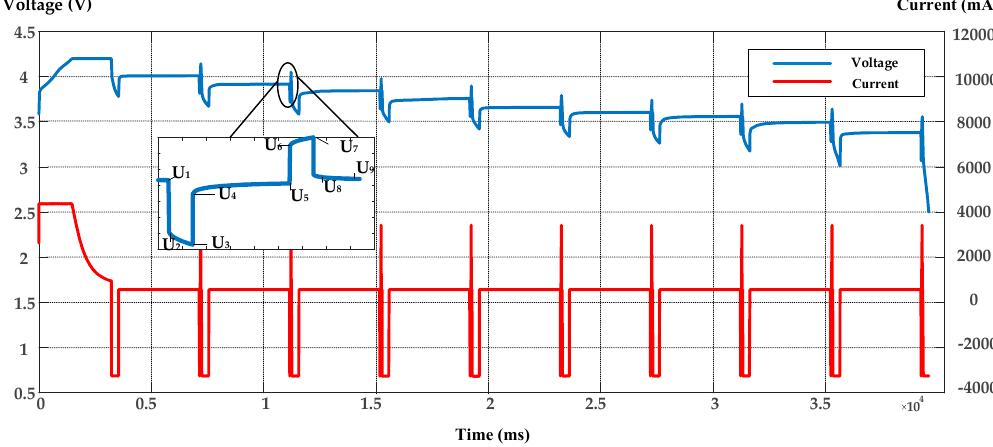
Figure 5. Voltage and current in the hybrid pulse power characteristic (HPPC) test.